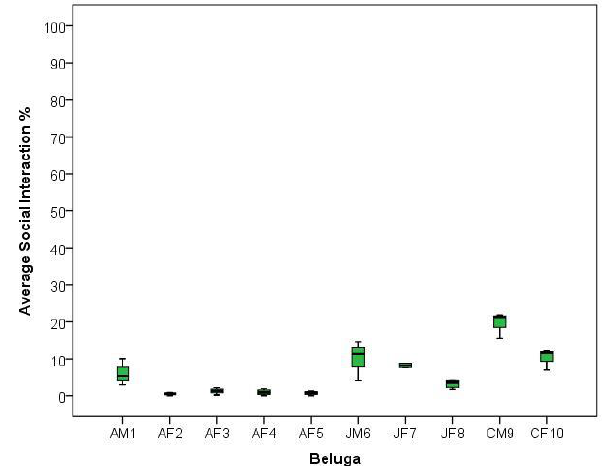
Figure 7. Boxplots of average social interactions percentage per individual beluga. Note the scale is a 100%.